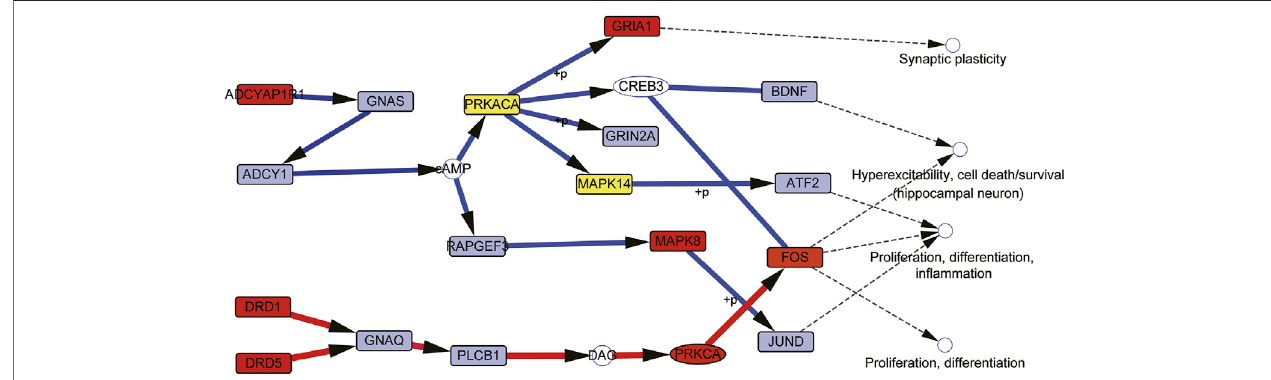
FIGURE 8 | Two cascade targeting modules merged by MTW-predicted cascade pathways. Red nodes mean the genes are both the targets of CGFC and pathogenetic genes of depression. Light green nodes mean the CGFC speci fi c target genes. Gray nodes represent the speci fi c pathogenetic genes.